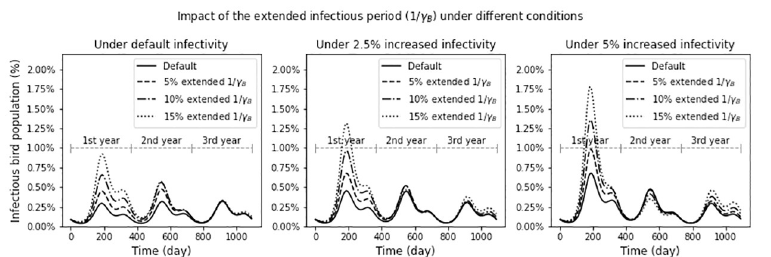
Fig 7. What-if scenarios with extended infectious period of EEE in bird hosts. The three plots show the trend in the infected bird population where the infectivity values ( α 5%, respectively. In each plot, trends that are changed by the increased infectious period by 5%, 10%, and 15% are presented.